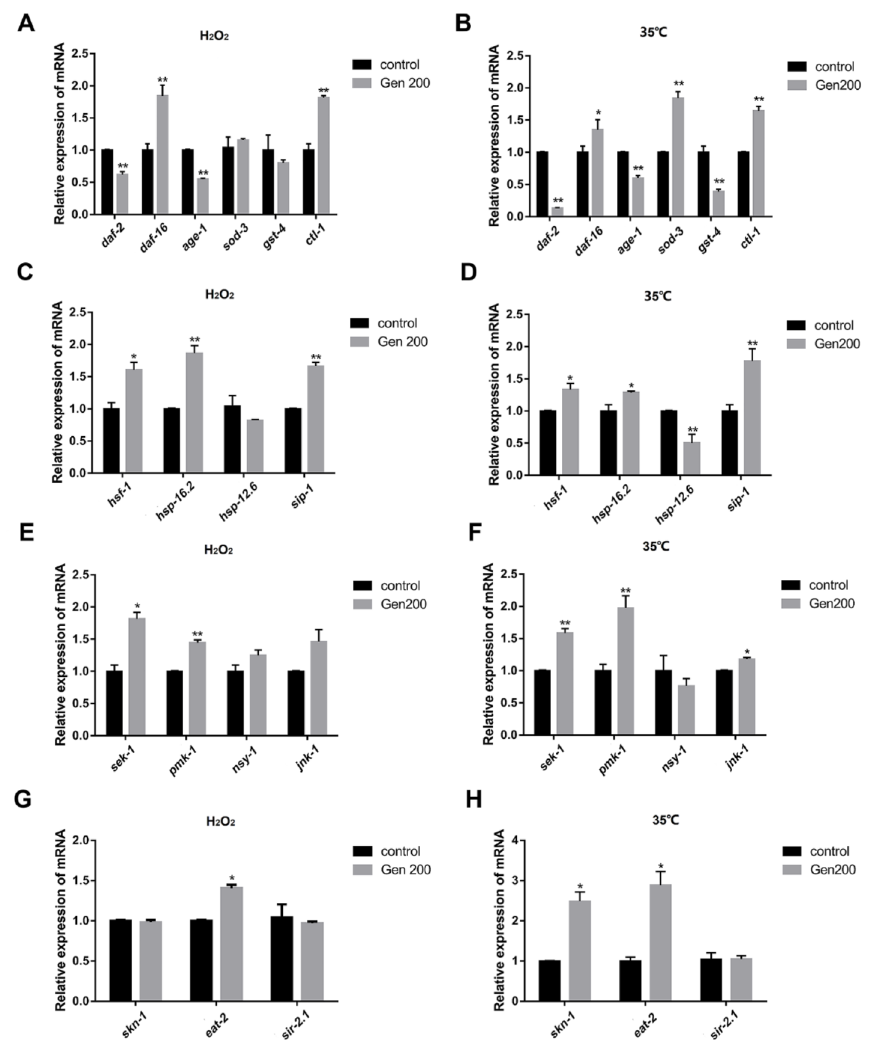
Figure 8. Under H 2 O 2 and 35 ◦ C conditions, 200 µ M genistein influences the mRNA level of stress resistance genes in the stage L4 C. elegans. ( A ) The effect of genistein on the mRNA of daf-16 , sod-3 , ctl-1 , daf-2 , age-1 , and gst-4 in C. elegans under H 2 O 2 conditions. ( B ) The effect of genistein on the mRNA of daf-16 , sod-3 , ctl-1 , daf-2 , age-1 , and gst-4 in C. elegans under 35 ◦ C conditions. ( C ) The effect of genistein on the mRNA of hsf-1 , hsp-16.2 , hsp-12.6 , and sip-1 in C. elegans under H 2 O 2 conditions. ( D ) The effect of genistein on the mRNA of hsf-1 , hsp-16.2 , hsp-12.6 , and sip-1 in C. elegans under 35 ◦ C conditions. ( E ) The effect of genistein on the mRNA of sek-1 , pmk-1 , nsy-1 , and jnk-1 in C. elegans under H 2 O 2 conditions. ( F ) The effect of genistein on the mRNA of sek-1 , pmk-1 , nsy-1 , and jnk-1 in C. elegans under 35 ◦ C conditions. ( G ) The effect of genistein on the mRNA of skn-1 , eat-2 , and sir-2.1 in C. elegans under H 2 O 2 conditions. ( H ) The effect of genistein on the mRNA of skn-1 , eat-2 , and sir-2.1 in C. elegans under 35 ◦ C conditions (* p < 0.05; ** p <